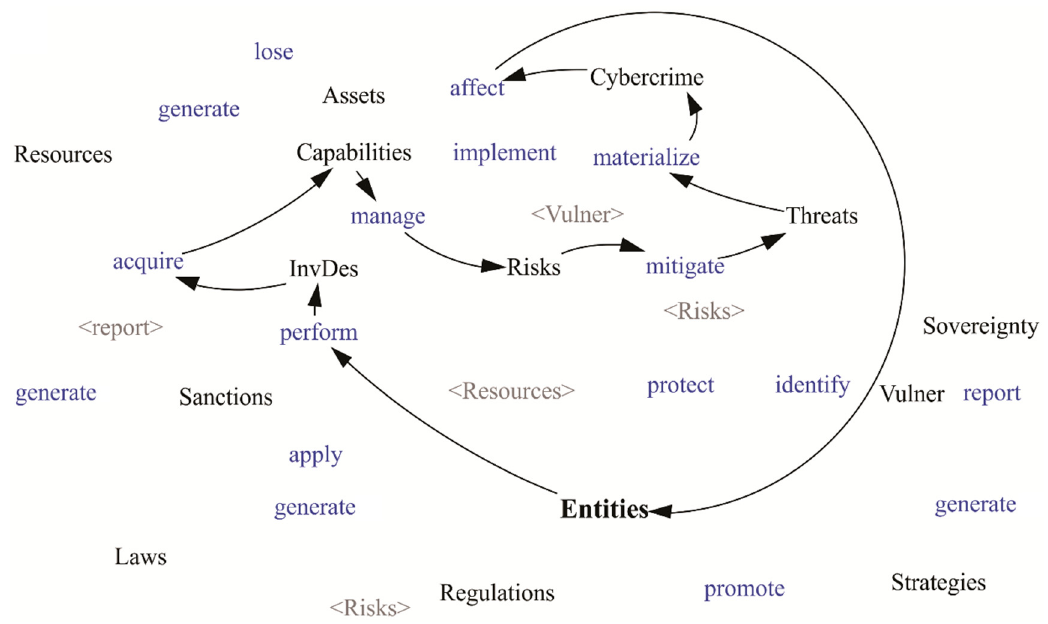
Figure 5. Risk management cycle.